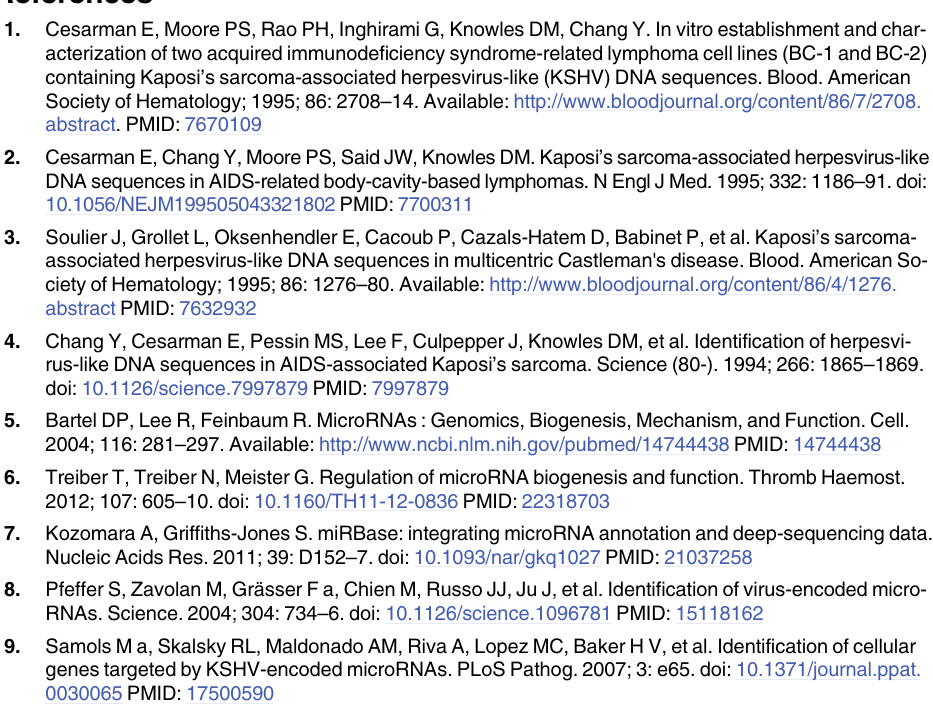
S1 Table. Primer sequences for PCR amplification of the 14q32 genomic region. Eight indi- vidual regions (~450bp) of the genomic DNA at 14q32 were probed using these custom-designed primers. Columns identify the primer name, direction, sequence as well as amplicon size. S2 Table. KSHV miRNA distribution in SLKK cell line. This table shows the read count and percentage representation of 25 mature KSHV miRNAs expressed in SLKK cells. S3 Table. Reads statistics for miRNAs expressed in KSHV-positive SLKK cells. Three inde- pendent experiments are displayed (A, B and C). Columns identify the replicate number, raw read counts for human or mature miRNAs, number of mapped miRNAs per species, which percentage these KSHV reads represented for each replicate or overall. These counts were ob- tained by mapping reads to either KSHV mature miRNAs or human mature